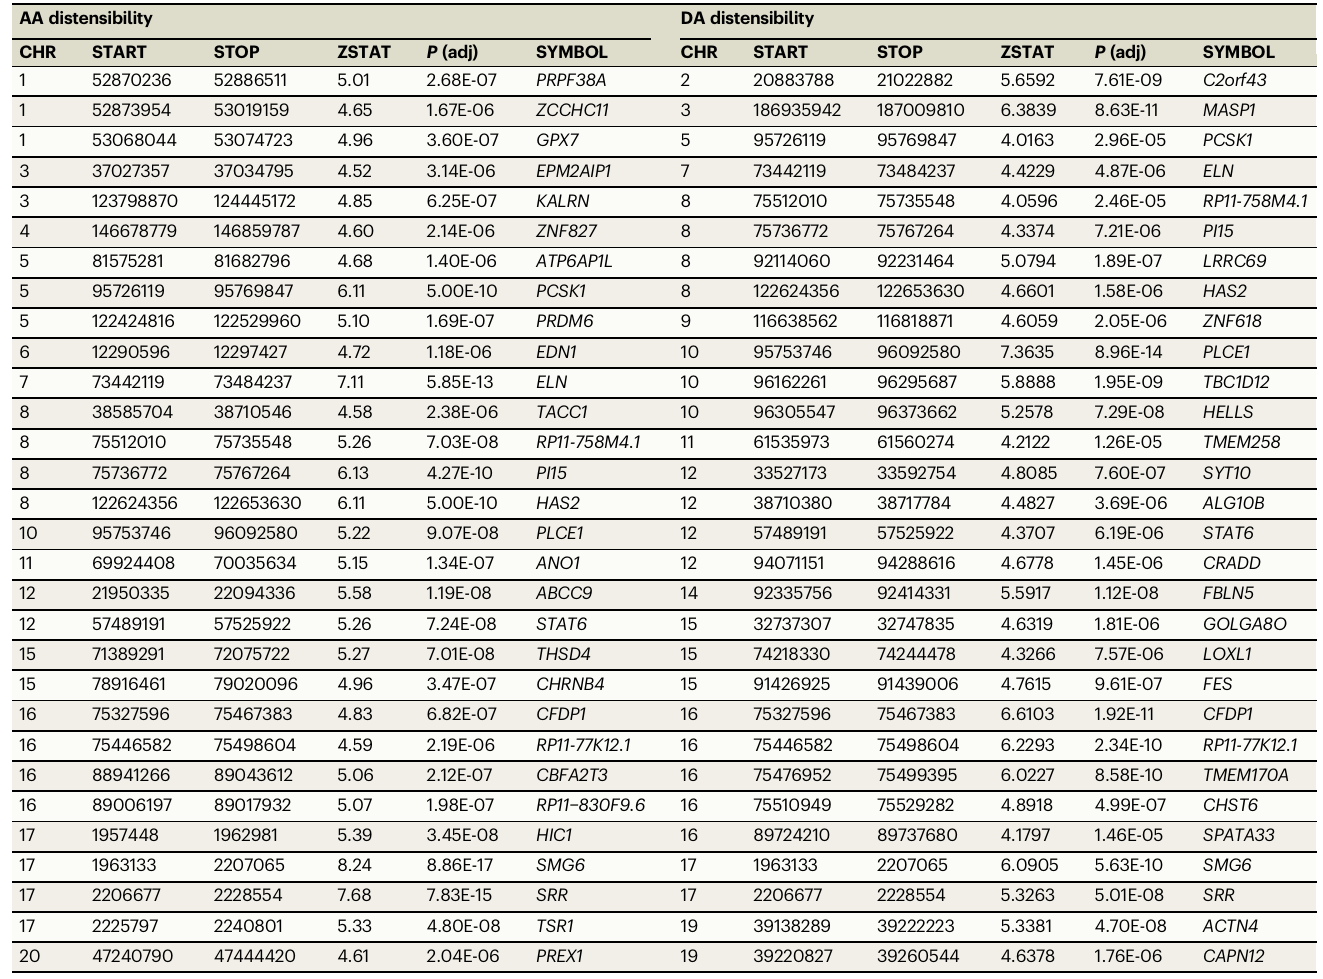
Table 3 | Most signi fi cant 30 genes associated with ascending and descending aortic distensibility (gene-based analysis using MAGMA v1.08 as implemented in FUMA